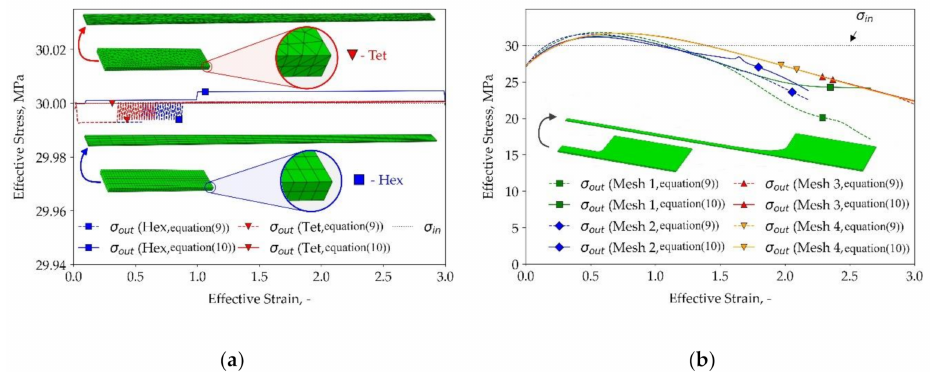
Figure 2. The e ff ect of finite element mesh and the way of force calculation on the output stress–strain curve: ( a ) for the box geometry realizing the ideal uniaxial tension conditions; ( b ) for the real specimen